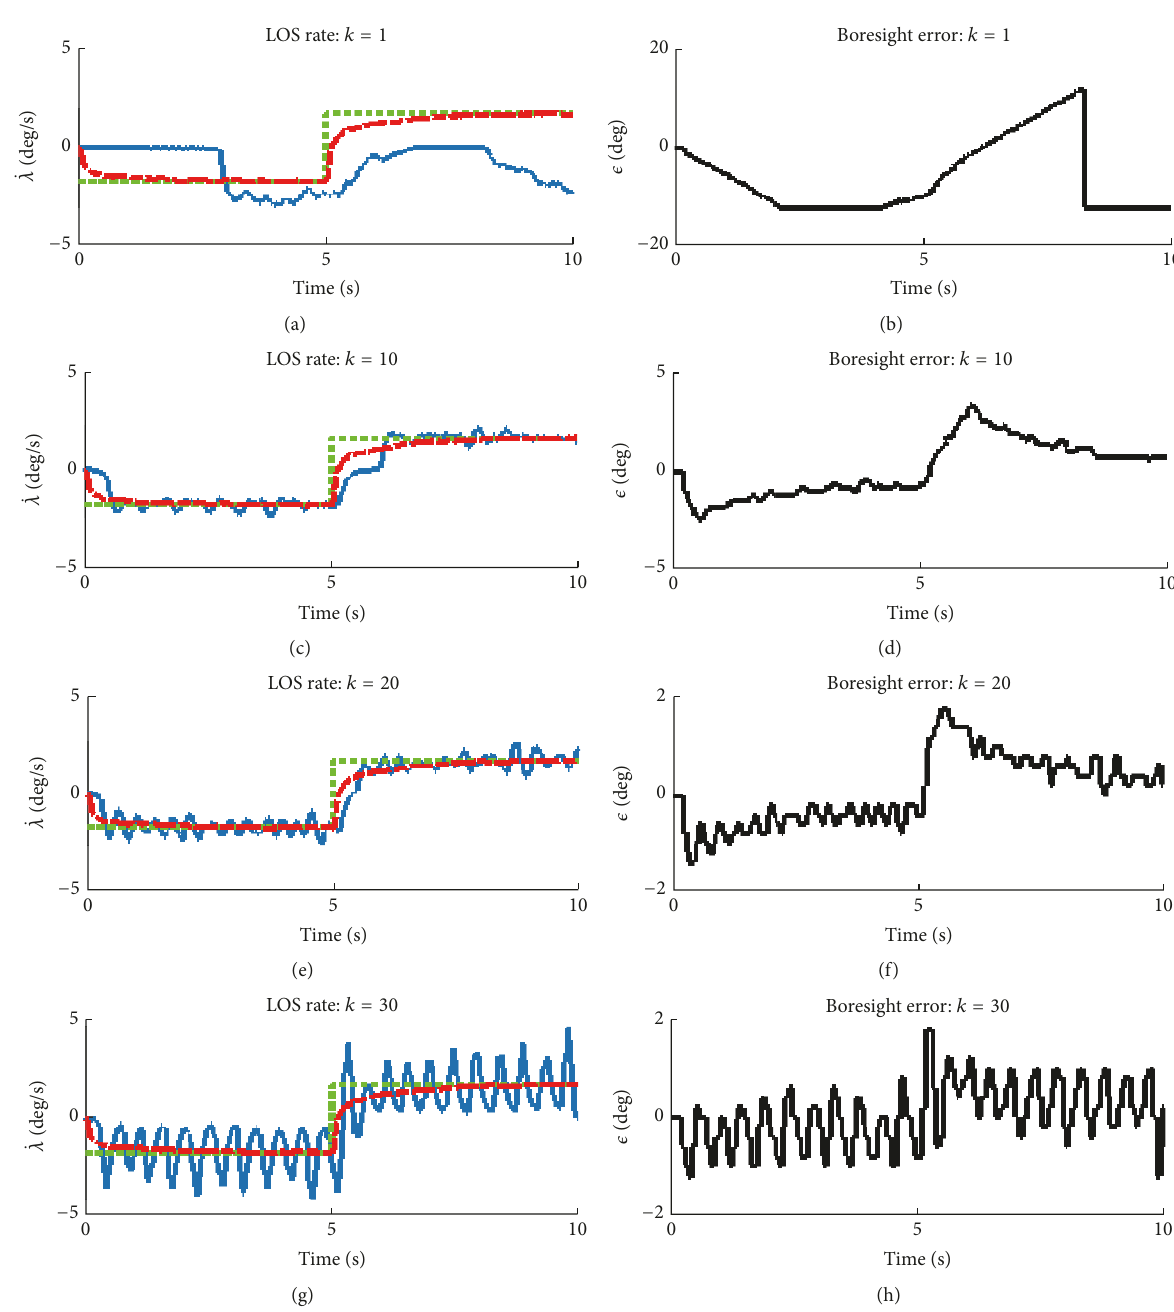
Figure 17: Seeker simulator tracking performance and missile boresight error corresponding to different 𝑘 during the HIL simulation. The green line is the command angular velocity for the target simulator. The red line is the response of the target simulator for the velocity command. The blue line is the seeker simulator angular velocity when it tracks the target. And the black line is missile boresight error corresponding to the tracking process shown in (a), (c), (e), and (g).